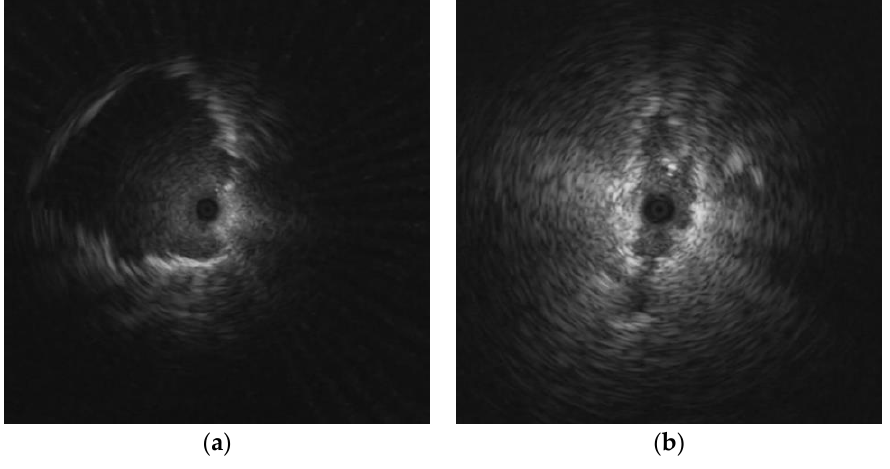
Figure 15. Misclassification of the single image-based model: ( a ) malignant lesion was misclassified